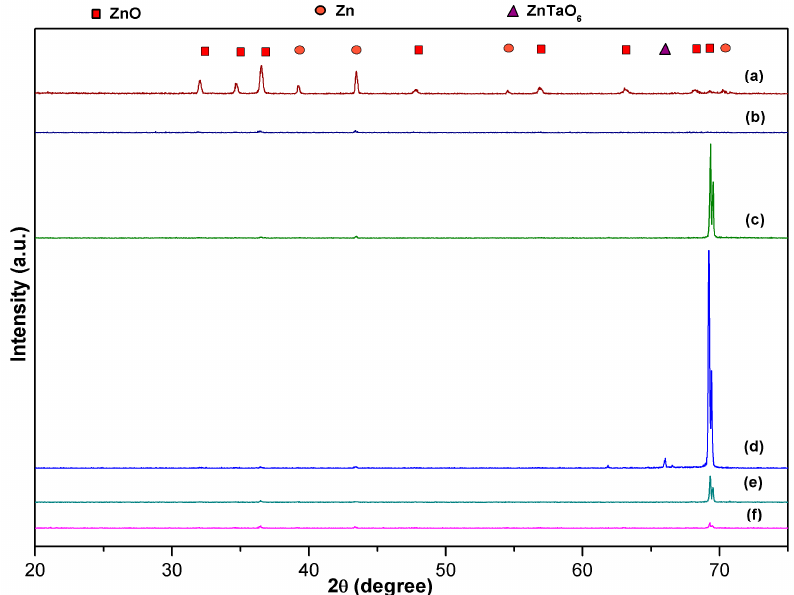
Figure 3. X-ray diffraction (XRD) patterns for ( a ) undoped ZnO film, and ZnO:Ta-doped films grown with a pellet weight of ( b ) 50 mg, ( c ) 100 mg, ( d ) 200 mg, ( e ) 250 mg, and ( f ) 300 mg of Ta 2 O 5 .